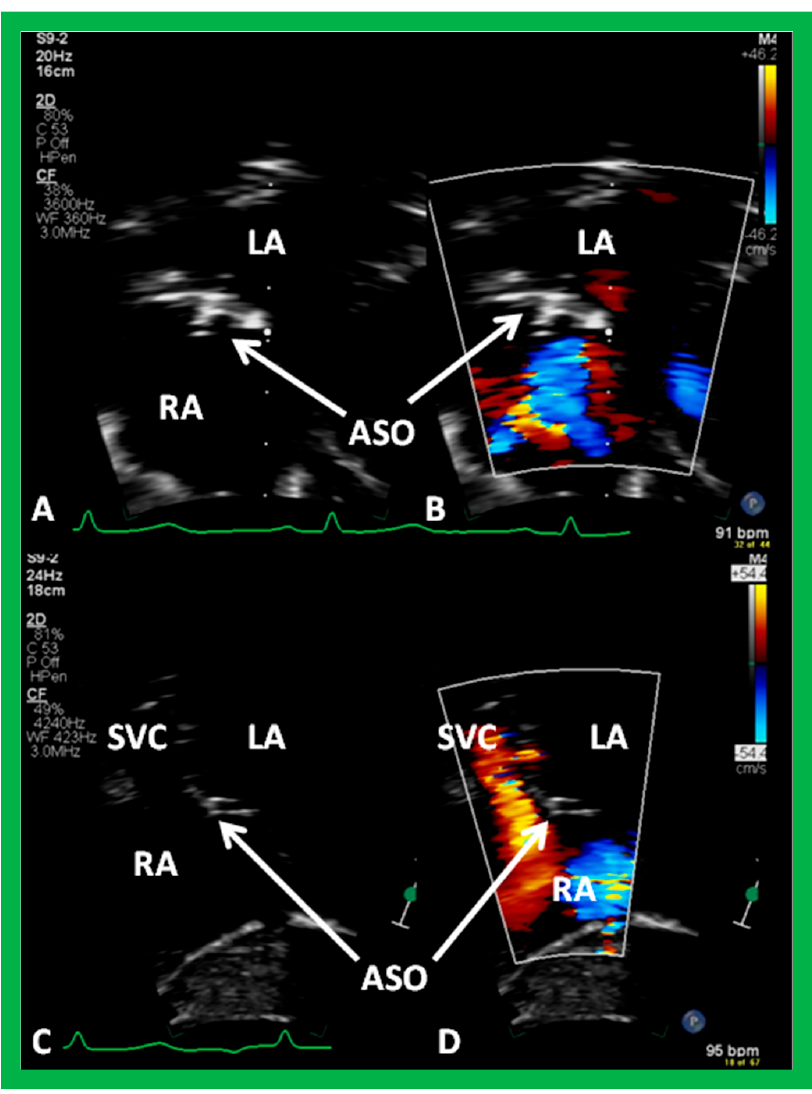
Figure 43. Echocardiographic images from subcostal long ( A , B ) and short ( C , D ) -axis transthoracic study of the atrial septum, illustrating Amplatzer Septal Occluder (ASO) closing an atrial defect three years after the device implantation; note good position of the ASO device ( A – D ) without residual shunt ( B , D ). Left atrium (LA), right atrium (RA), and superior vena cava (SVC) are labeled.